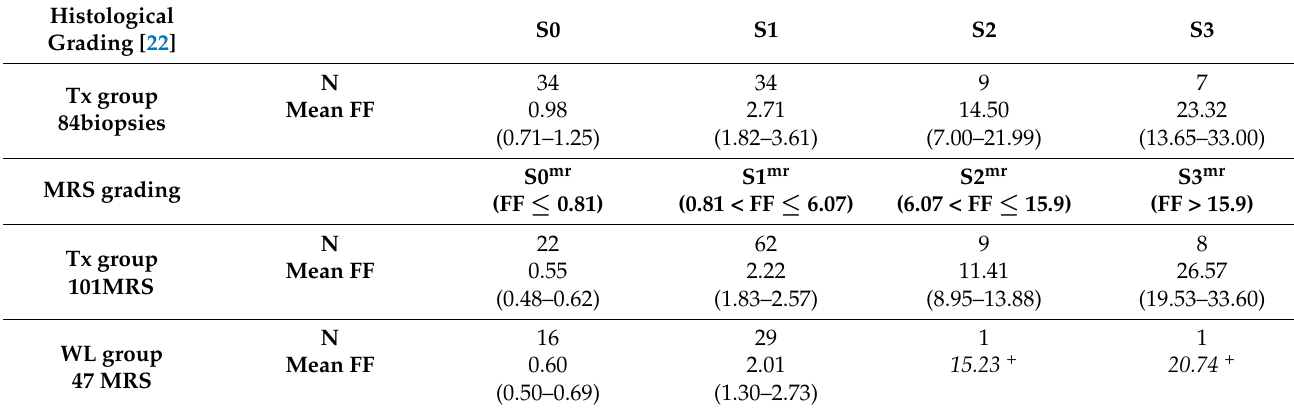
Table 2. Distribution of fatty acid fractions (FF) [%] in liver transplant recipient (Tx) and candidate (WL) groups classified according to histological and MRS steatosis grades. (95% confidence intervals are given in parentheses.).